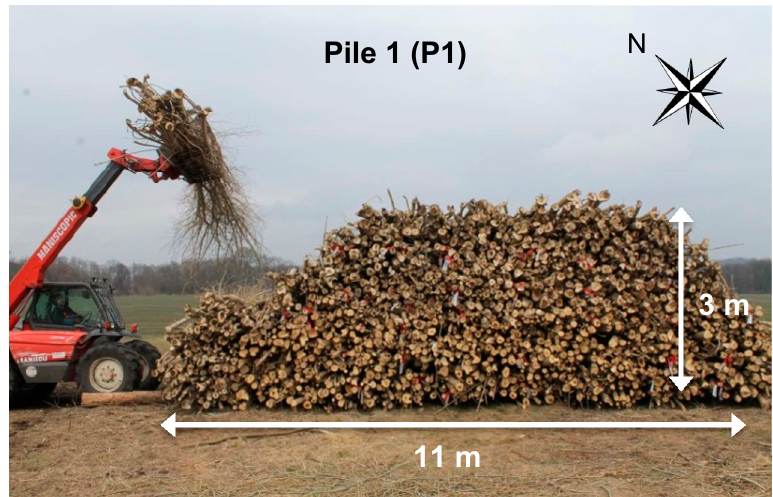
Figure 2. Construction of a pile of whole poplar trees with the help of a telescopic loader at Table 1. in Potsdam.